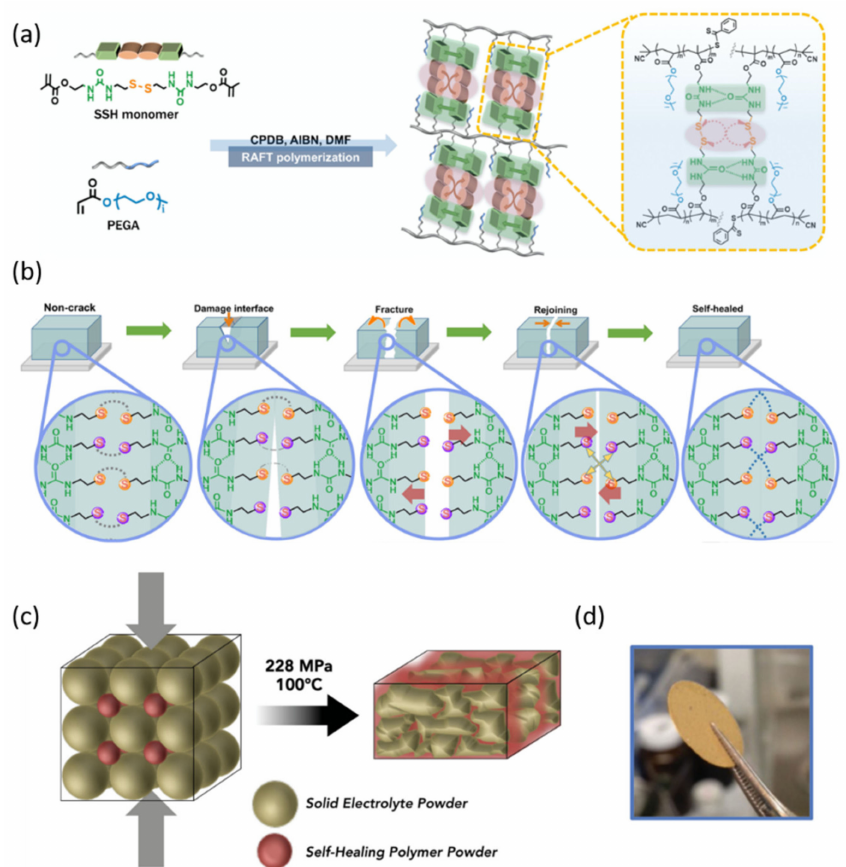
Figure 7. Self-healing strategies exploited in the electrolytes of LIBs. ( a ) schematic of the forma- tion of PEG-SSH and ( b ) schematic of self-healing process with disulfide bonds and hydrogen bonds [94]. Copyright 2020, American Chemical Society; ( c ) schematic diagram of forming a solid electrolyte in polymer matrix membrane and a ( d ) picture of a free-standing SEPM separator 100 µ m in thickness [95]. Copyright 2019, John Wiley and